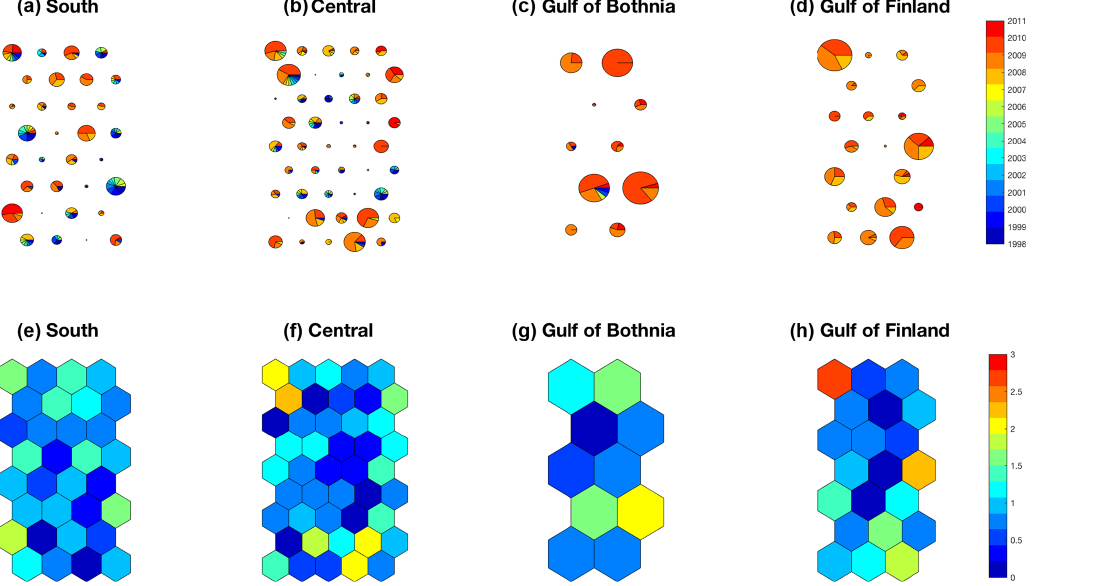
Figure 8. Panels (a) , (b) , (c) , and (d) are the distributions of the years of each data in each class for each basin SOM. Panels (e) , (f) , (g) , and (h) are the percentages of the total number of data present in each class of the different basins’ SOM. The size of the circles in the top figures is also representative of the percentage of the total number of data present in each class of the different basins’